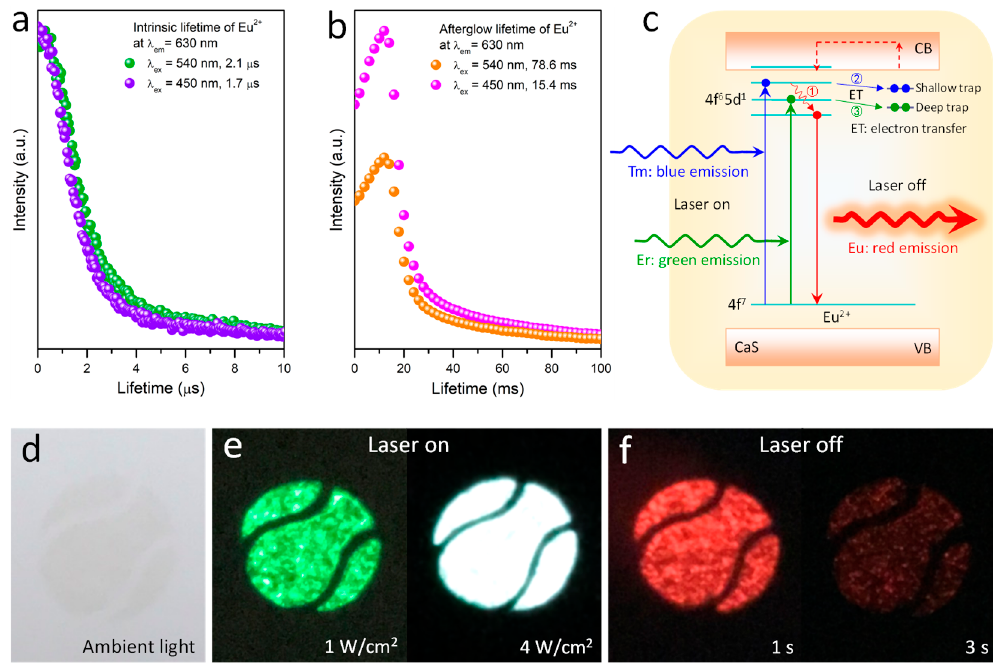
Figure 3. ( a , b ) Intrinsic lifetime and afterglow lifetime of CaS:Eu 2+ under nanosecond and second pulsed laser excitations, respectively. ( c ) Schematic representation of excitation and luminescence dynamics of CaS:Eu 2+ crystals. ( d – f ) Color changes of the printed pattern by using the hybrid ink under 975 nm irradiation at various power densities and when 975 nm laser is off.